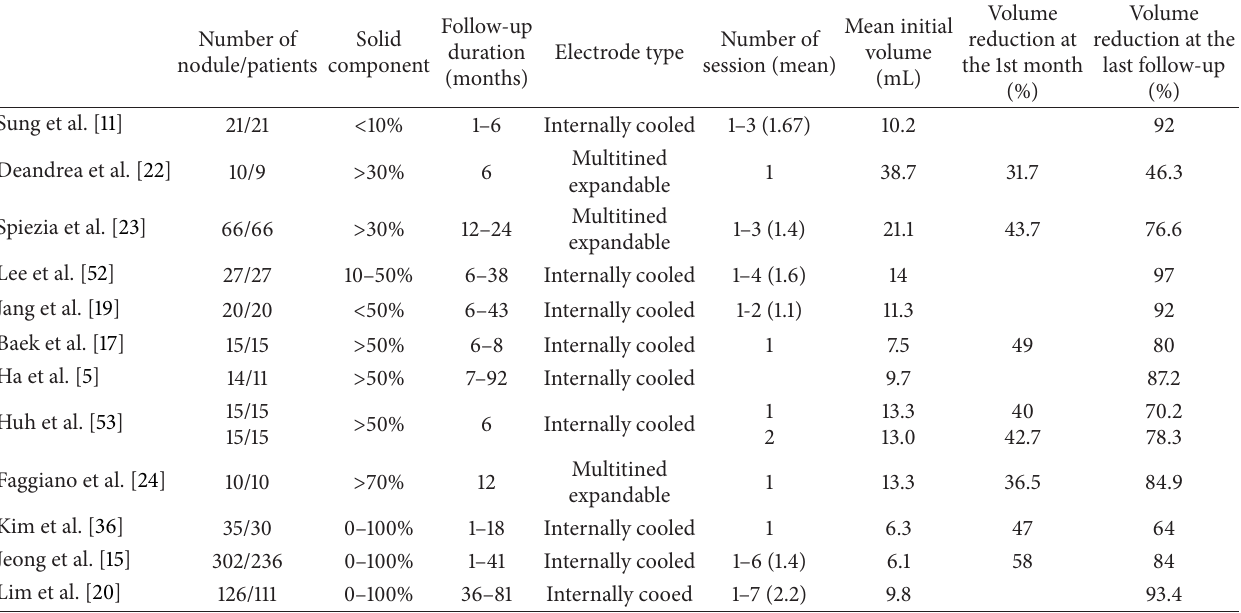
Table 1: Result of volume reduction in patients who underwent radiofrequency ablation for cold thyroid